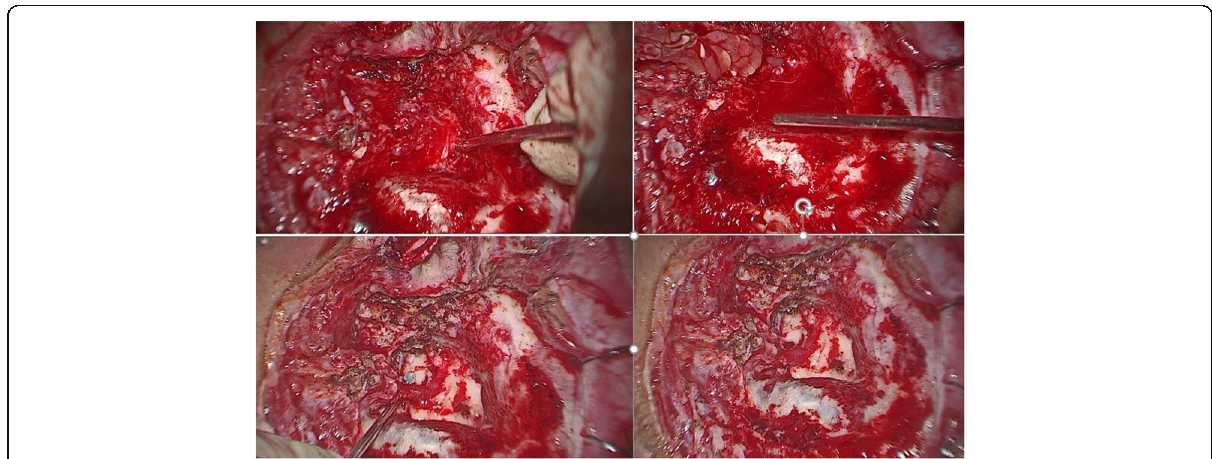
Fig. 3 Upper left: after partial mastoidectomy and debulking, tumor was bloody filling the middle ear. Upper right: tumor filling the eustachian tube being removed with cumbersome bleeding in the cavity. Lower left: after the completion of the debulking, showing instrument passing in the retro-facial tract where tumor most likely affected the facial nerve. Lower right: final cavity before closure with maximal debulking performed and bleeding